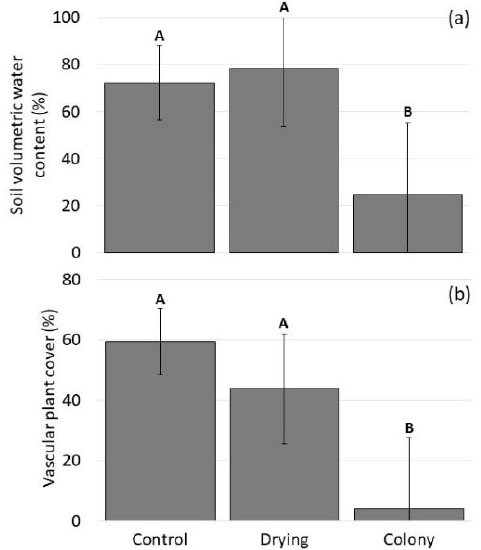
Figure 8. Least-squares means estimates of ( a ) soil volumetric water content and ( b ) vegetation cover from the linear mixed effects models. Error bars represent 95% confidence intervals and bars with different letters are significantly different.